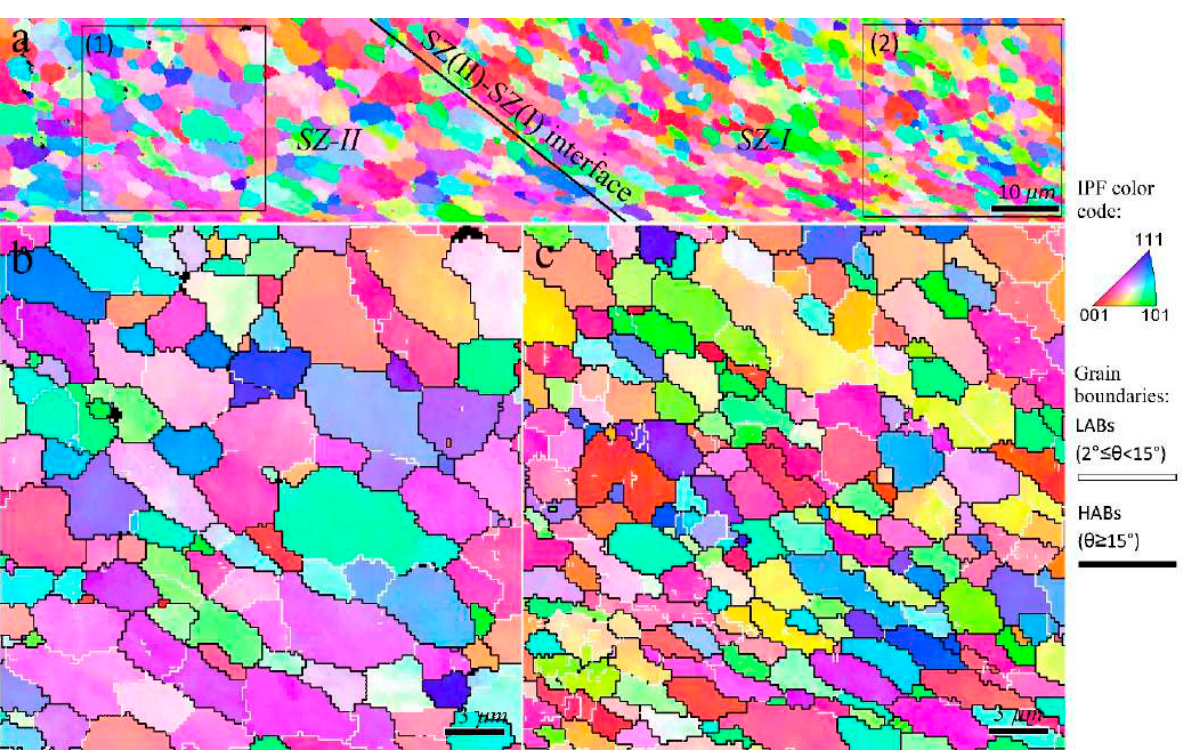
Figure 6. ( a ) Inverse pole figure maps of the interfacial zone between SZ-II and SZ-I regions in 1-pass sample indicated by rectangle 4 in Figure 2b. Higher magnification of zones 1 and 2 indicated in ( a ) are illustrated in ( b ) and ( c ), respectively.